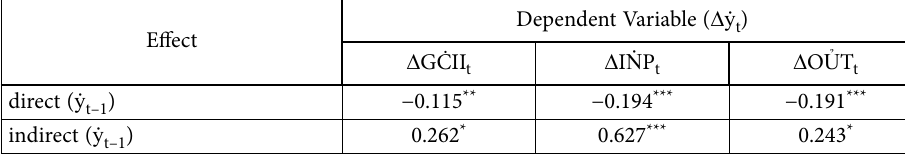
Table 2. Direct and indirect effects of lagged Innovation